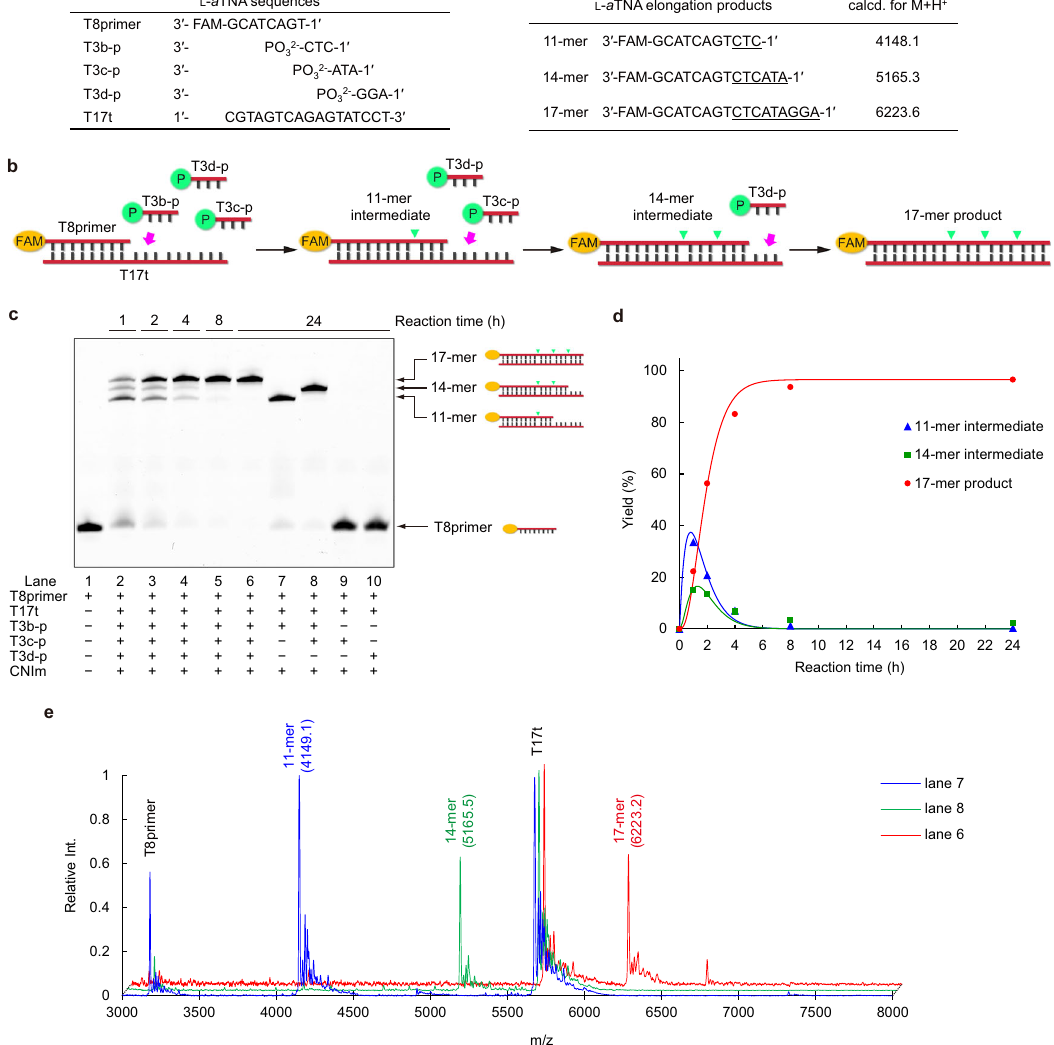
Fig. 4 Sequential, template-directed ligation of trimers. a Sequences used for sequential ligation of trimers. b Schematic illustration of the sequential, template-directed ligation of trimers. c Denaturing PAGE analysis of sequential ligation. Lane 1, T8primer as a marker; lane 2, reaction products after 1 h; lane 3, reaction products after 2 h; lane 4, reaction products after 4 h; lane 5, reaction products after 8 h; lane 6, reaction products after 24 h; lane 7, reaction products in the absence of T3c-p and T3d-p; lane 8, reaction products in the absence of T3d-p; lane 9, reaction products in the absence of T3b-p and T3d-p; and lane 10, reaction products in the absence of T3b-p and T3c-p. Conditions: [T8primer] = 0.9 μ M, [T3b-p] = [T3c-p] = [T3d-p] = 50 μ M, [T17t] = 1.0 μ M, [NaCl] = 100 mM, [MnCl 2 ] = 20 mM, [CNIm] = 20 mM, 4 °C. Source data are provided as a Source Data fi le. d Ligation yield determined from PAGE. Blue triangle, green square, and red circle represent 11-mer intermediate, 14-mer intermediate, and 17-mer full-length product, respectively. Source data are provided as a Source Data fi le. e MALDI-TOF MS spectra and observed m / z of reaction mixture containing all components analyzed after 24 h (red), of reaction products in the absence of T3c-p and T3d-p, which yielded only 11-mer (blue line), and of reaction products in the absence of T3d-p, which yielded 14-mer (green line). Peaks corresponding to the template (T17t) and T8primer were also observed. Source data are provided as a Source Data fi